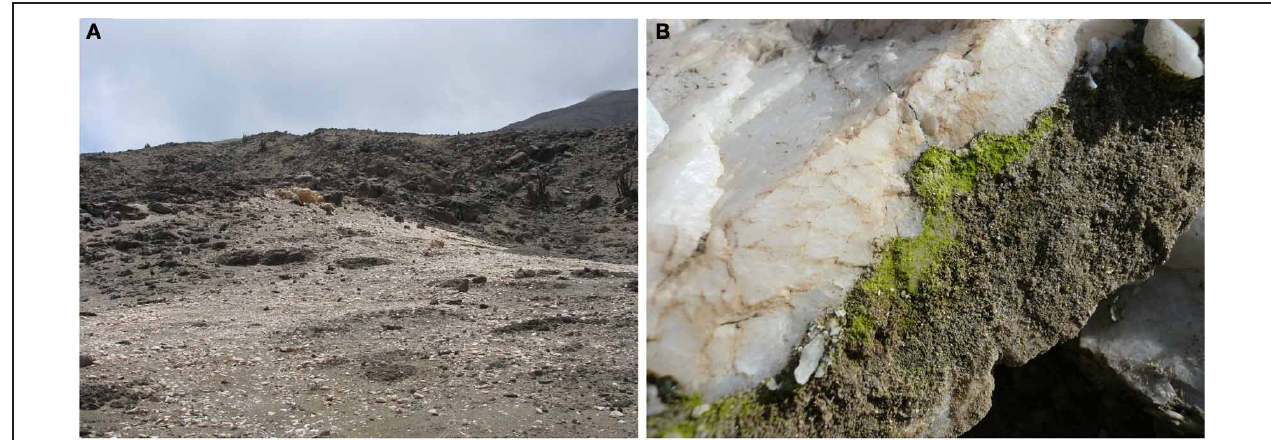
FIGURE 5 | The quartz field site. (A) Image showing the quartz outcrop. (B) A quartz colonized with a hypolithic biofilm.